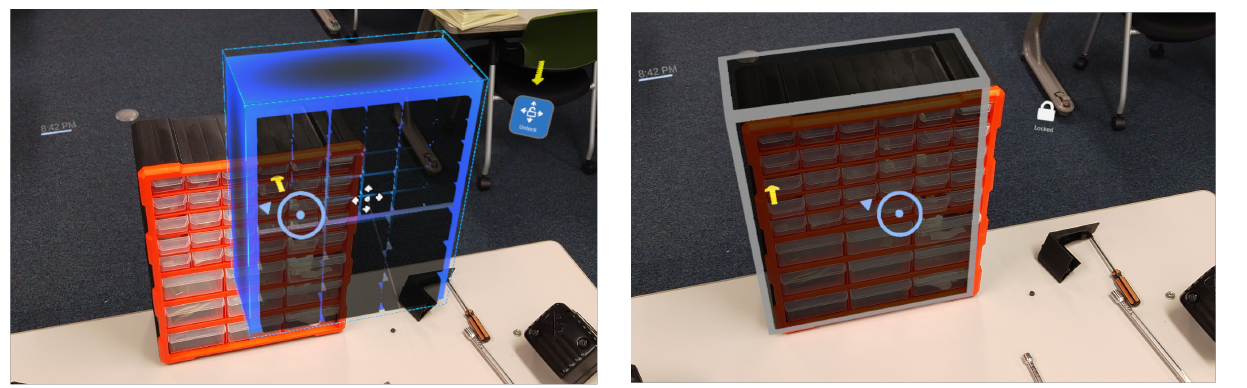
Figure 12. The color change that occurs in the main interface when the user interacts and does not interact.